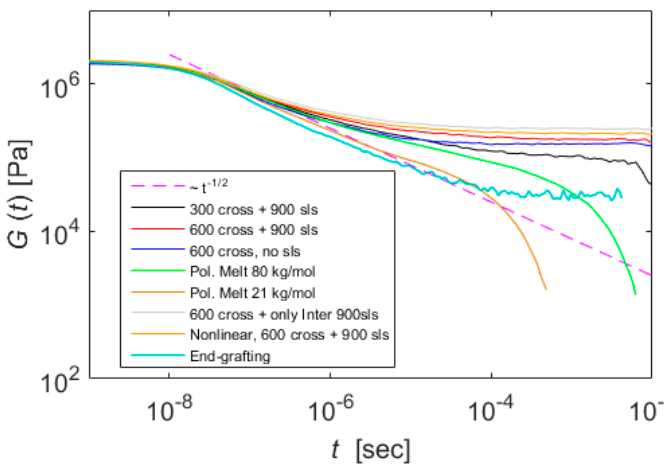
Figure 7. Stress relaxation functions of various polymer networks at different crosslink and slip spring densities obtained from random crosslinking. Two curves corresponding to cis -PI polymer melts consisting of monodisperse linear chains of different molar masses (i.e., 80 kg/mol and 21 kg/mol) are also included to indicate the different behavior between crosslinked and uncrosslinked polymer networks. In the case of these two curves, the stress relaxation functions were fitted to sums of Maxwell modes [49].